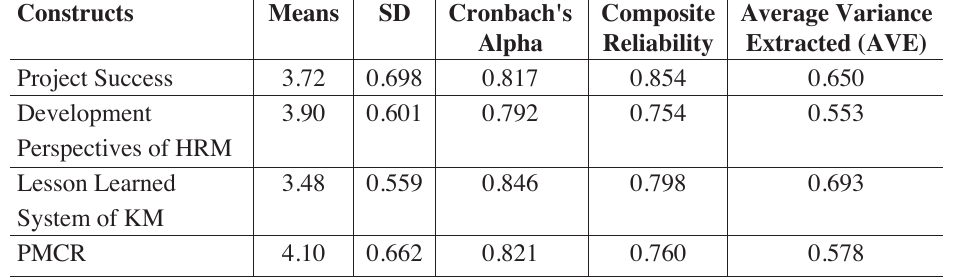
Table 2: Descriptive Statistics, Reliability, and Validity